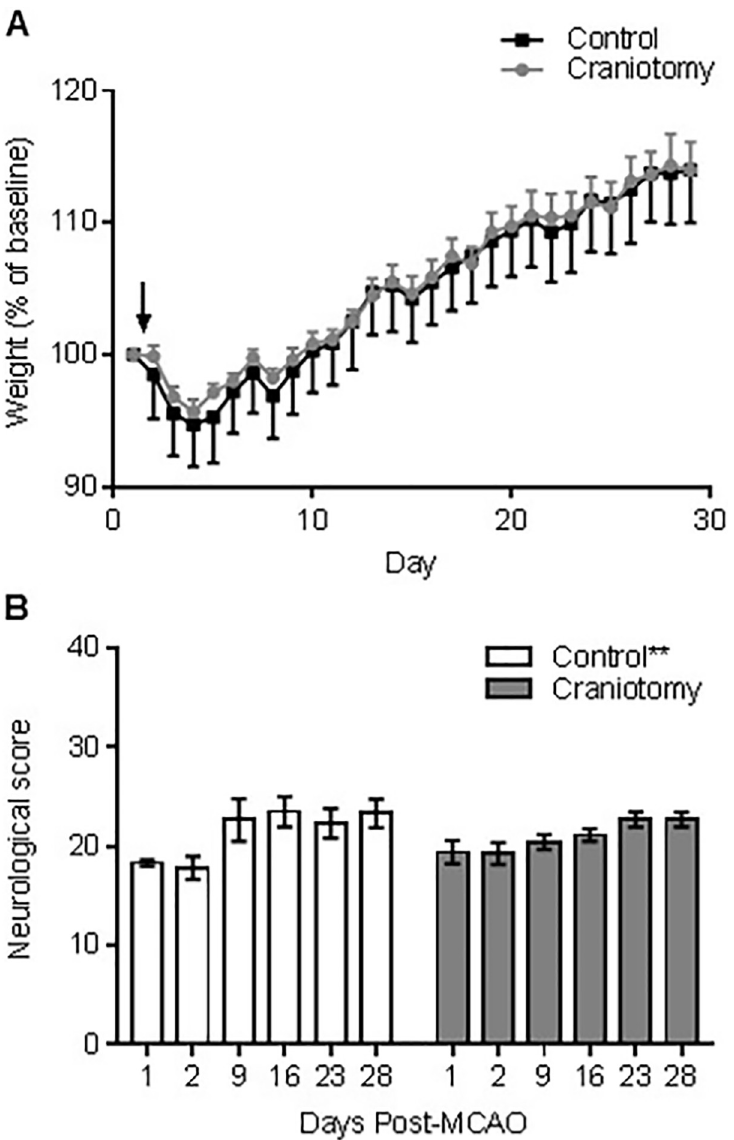
Fig 3. Effect of craniotomy on body weight and neurological score post-MCAO. (a) Body weights were recorded daily as a measure of wellbeing and both groups significantly increased weight over time (P = < 0.0001). Arrow represents the point of MCAO. (b) A 28-point neurological score was used to measure functional outcome, craniotomy had no significant effect on neurological score, however there was a significant main effect of time ( �� P = < 0.001). Data is displayed as mean ± SEM; control n = 6, craniotomy n =